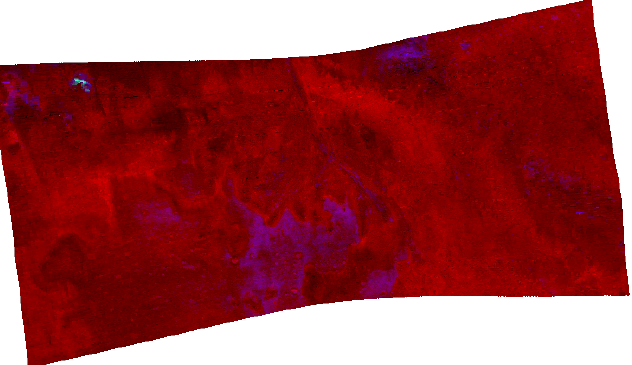
Figure 7. The MAF browse product of the MTRDR product HRL000040FF. This image browse product shows information related to mafic mineralogy and denotes olivine and Fe-phyllosilicate in red color [26].